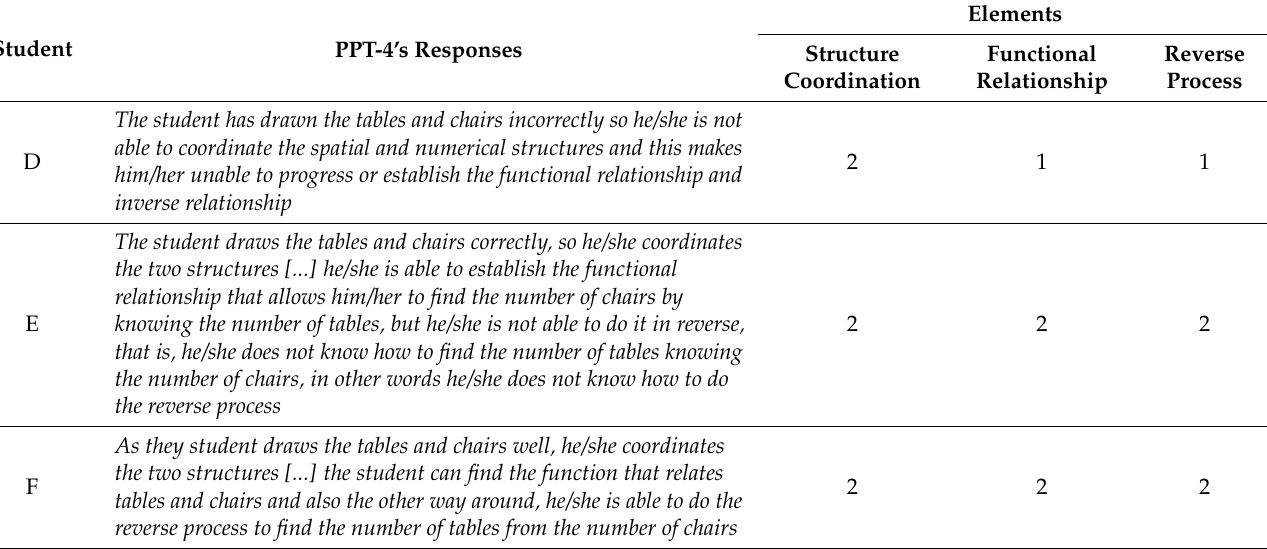
Table 10. PPT-4’s responses from Profile I.